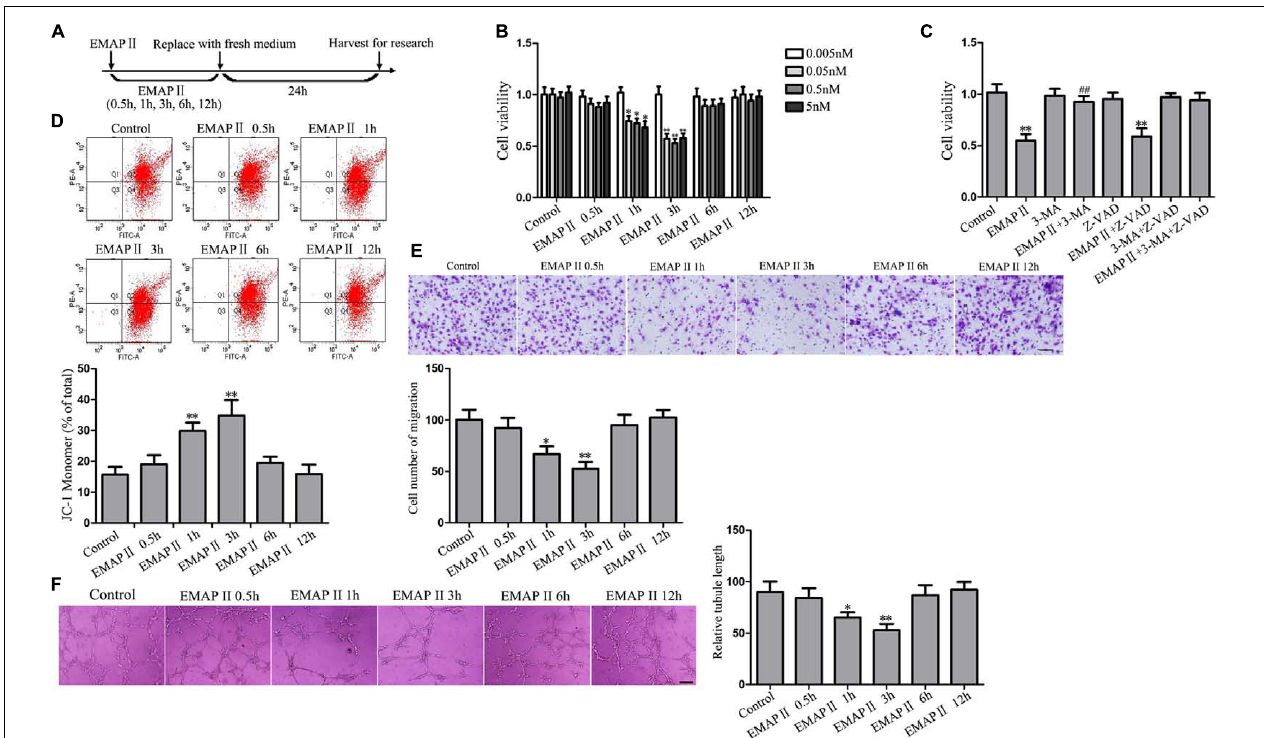
FIGURE 1 | Effect of EMAP II on the viability, mitochondrial membrane potential (MMP), migration and tube formation of GBM-induced endothelial cells (GECs). (A) Timeline of the research with EMAP II. (B) Effect of EMAP II on the GECs viability after treatment with 0.005, 0.05, 0.5, and 5 nM EMAP II for 0.5, 1, 3, 6, and 12 h. (C) Effect of EMAP II, 3-MA, and Z-VAD on the GECs viability after treatment with 0.05 nM EMAP II for 3 h. (D) Effect of EMAP II on the MMP of GECs by JC-1 assay. (E) Effect of EMAP II on the GECs migration after treatment with 0.05 nM EMAP II for 0.5, 1, 3, 6, and 12 h. Scale bar = 80 µ m. (F) Effect of EMAP II on the GECs tube formation after treatment with 0.05 nM EMAP II for 0.5, 1, 3, 6, and 12 h. Scale bar = 100 µ m. Data represent means ± SD ( n = 5, each). ∗ P < 0.05 and ∗∗ P < 0.01 vs. control group, ## P < 0.01 vs. EMAP II